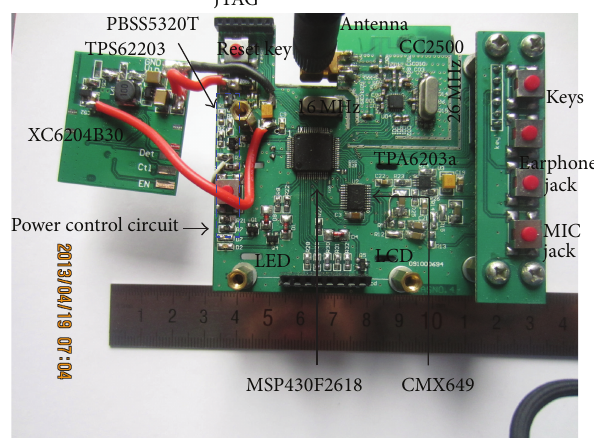
Figure 2: ANODE/CNODE